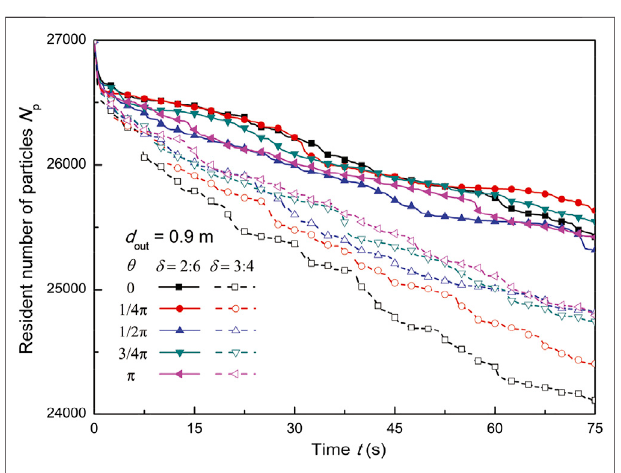
FIGURE 5 | Number of resident particles with different included angles θ of z-particles when d out (cid:1) 0.9 m.